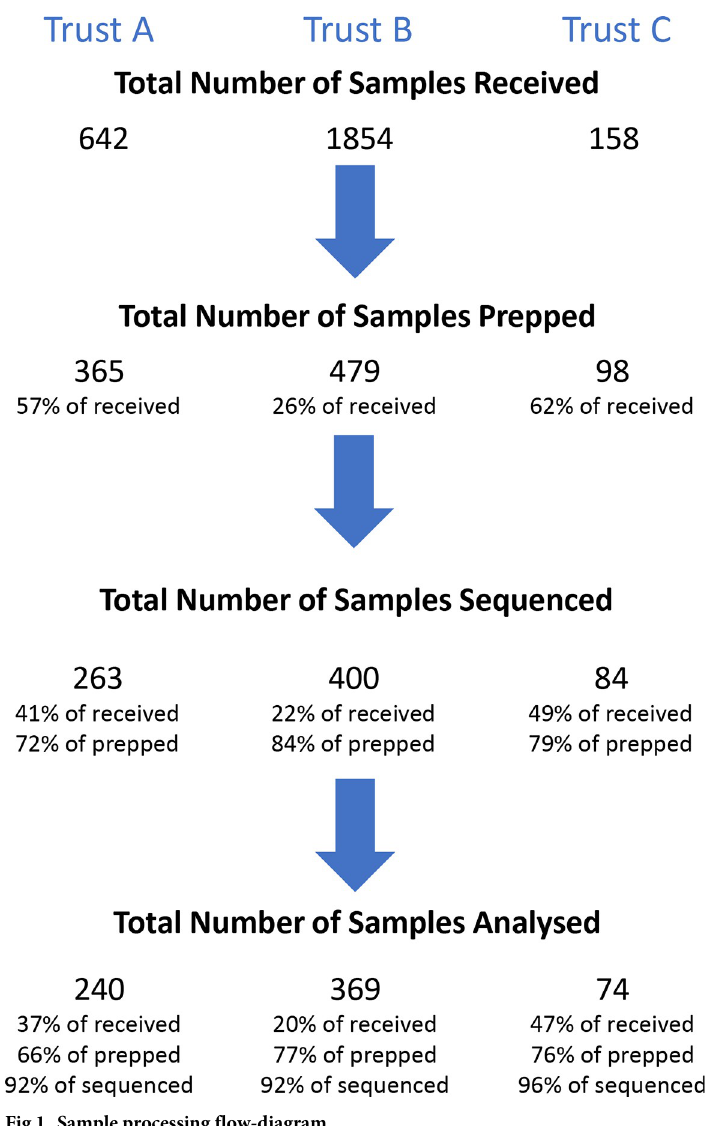
Fig 1. Sample processing